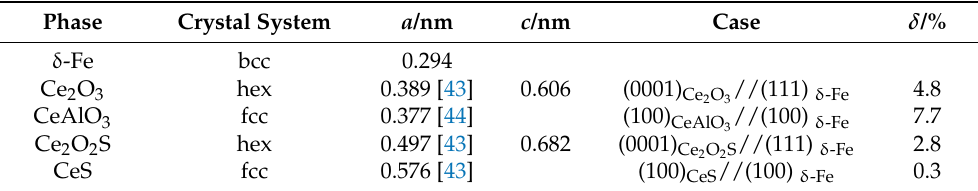
Table 5. Calculation results of atomic structure mismatch between Ce-modified products and the solidification